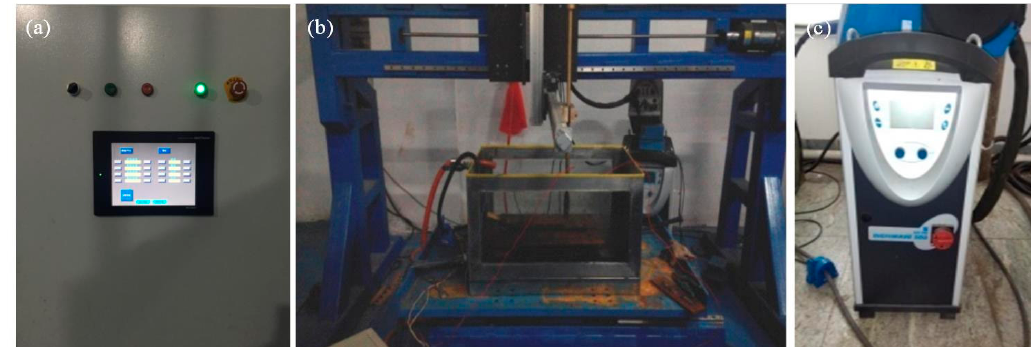
Figure 1. Automatic underwater welding control platform: ( a ) control cabinet; ( b ) welding platform; ( c ) welding power supply.